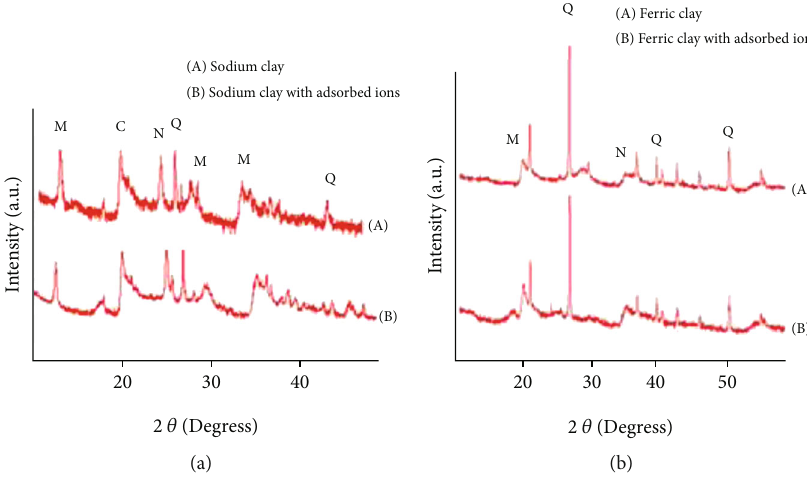
Figure 2: X-ray di ff ractogram of the clays before (a) and after (b) the four metal ions adsorption. 2 (a) Sodium clay and 2 (b) ferric clay. Ckaolinite (Al